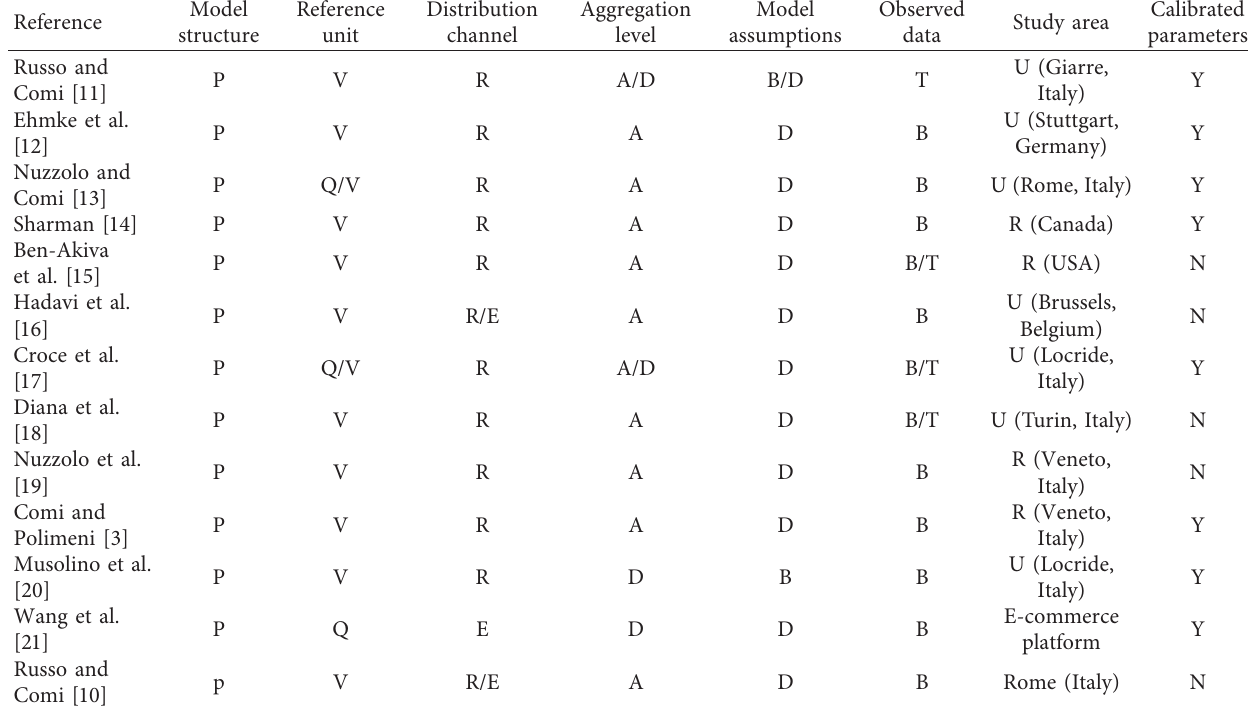
Table 1: Classification of a selection of papers using big data to estimate freight demand